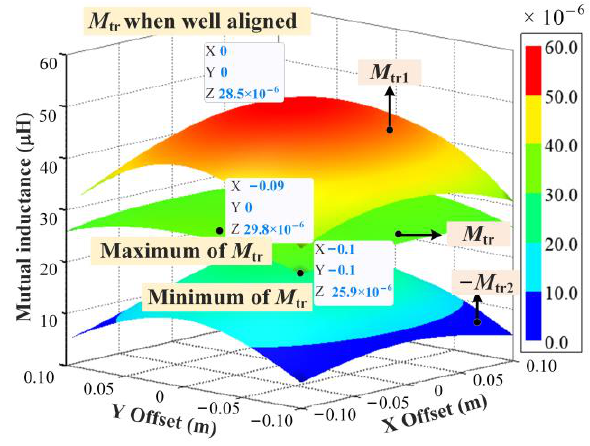
Figure 8. Offset characteristic maps in all directions with the employment of cores.